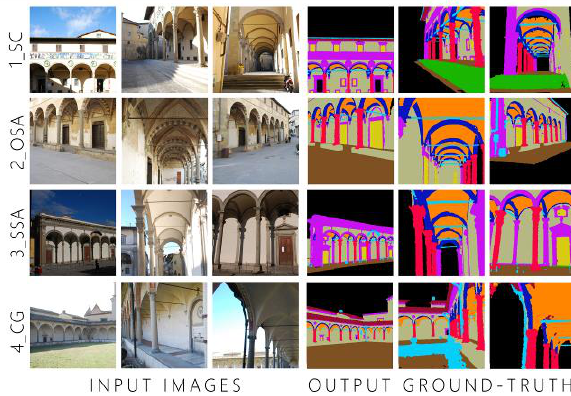
Figure 1 . Examples of the images in the dataset with the corresponding ground-truth.